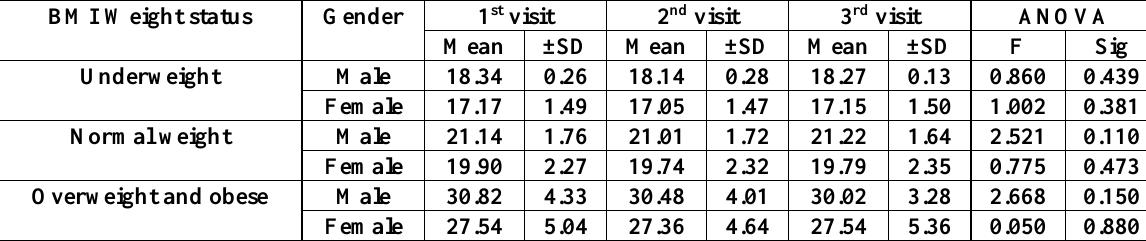
Table 2: Descriptive and statistical test of changes of means of BMI of each weight status group between visits by gender